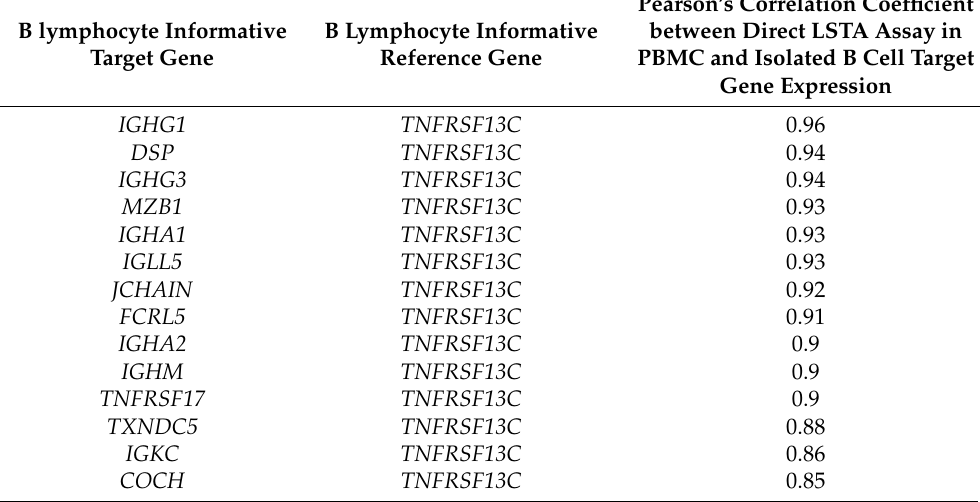
Table 3. A shortlist of B-lymphocyte target genes that can be reliably measured in PBMC without the need for prior cell